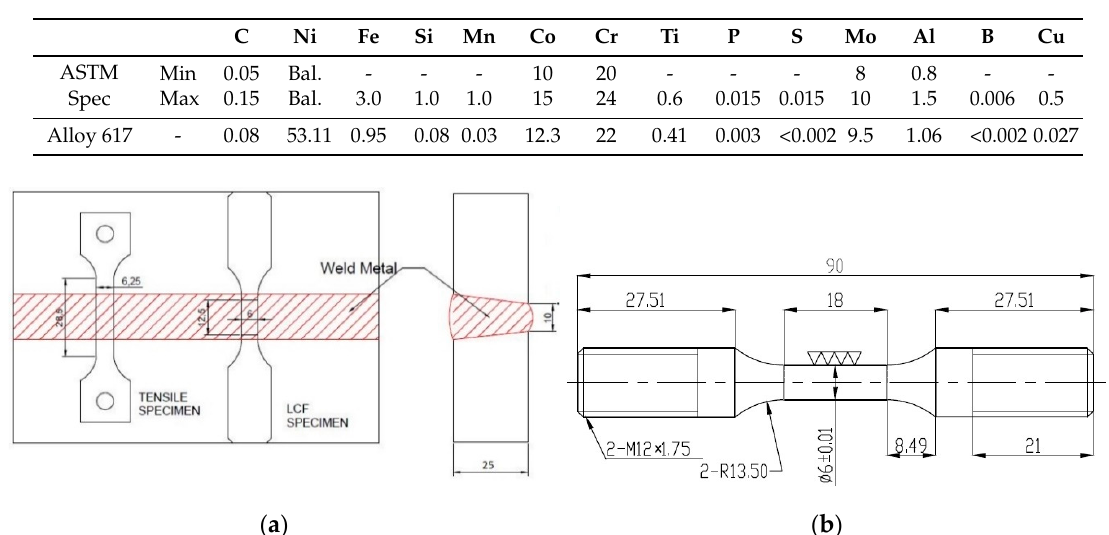
Figure 2. ( a ) The weld pad configuration of weldment specimens; ( b ) The cylindrical low cycle fatigue (LCF) specimen’s shape and geometry.